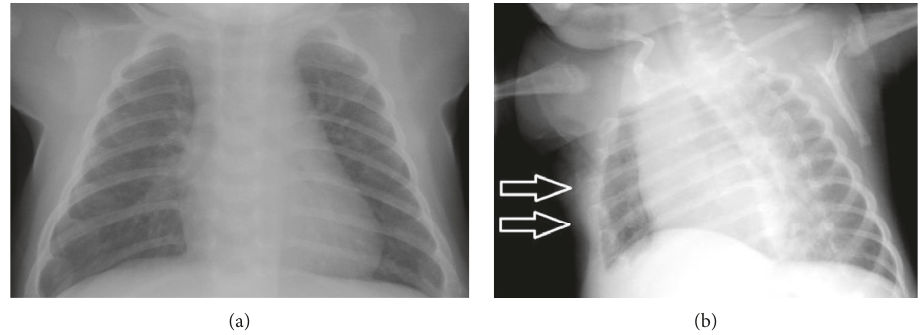
Figure 2: Pretreatment AP (a) and oblique (b) views of the chest show widening and cupping of the costochondral